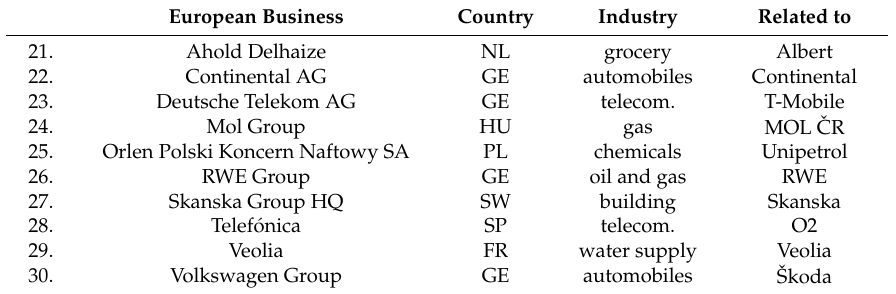
Table 3. Case study—second group—large European businesses related to Czech business from the first